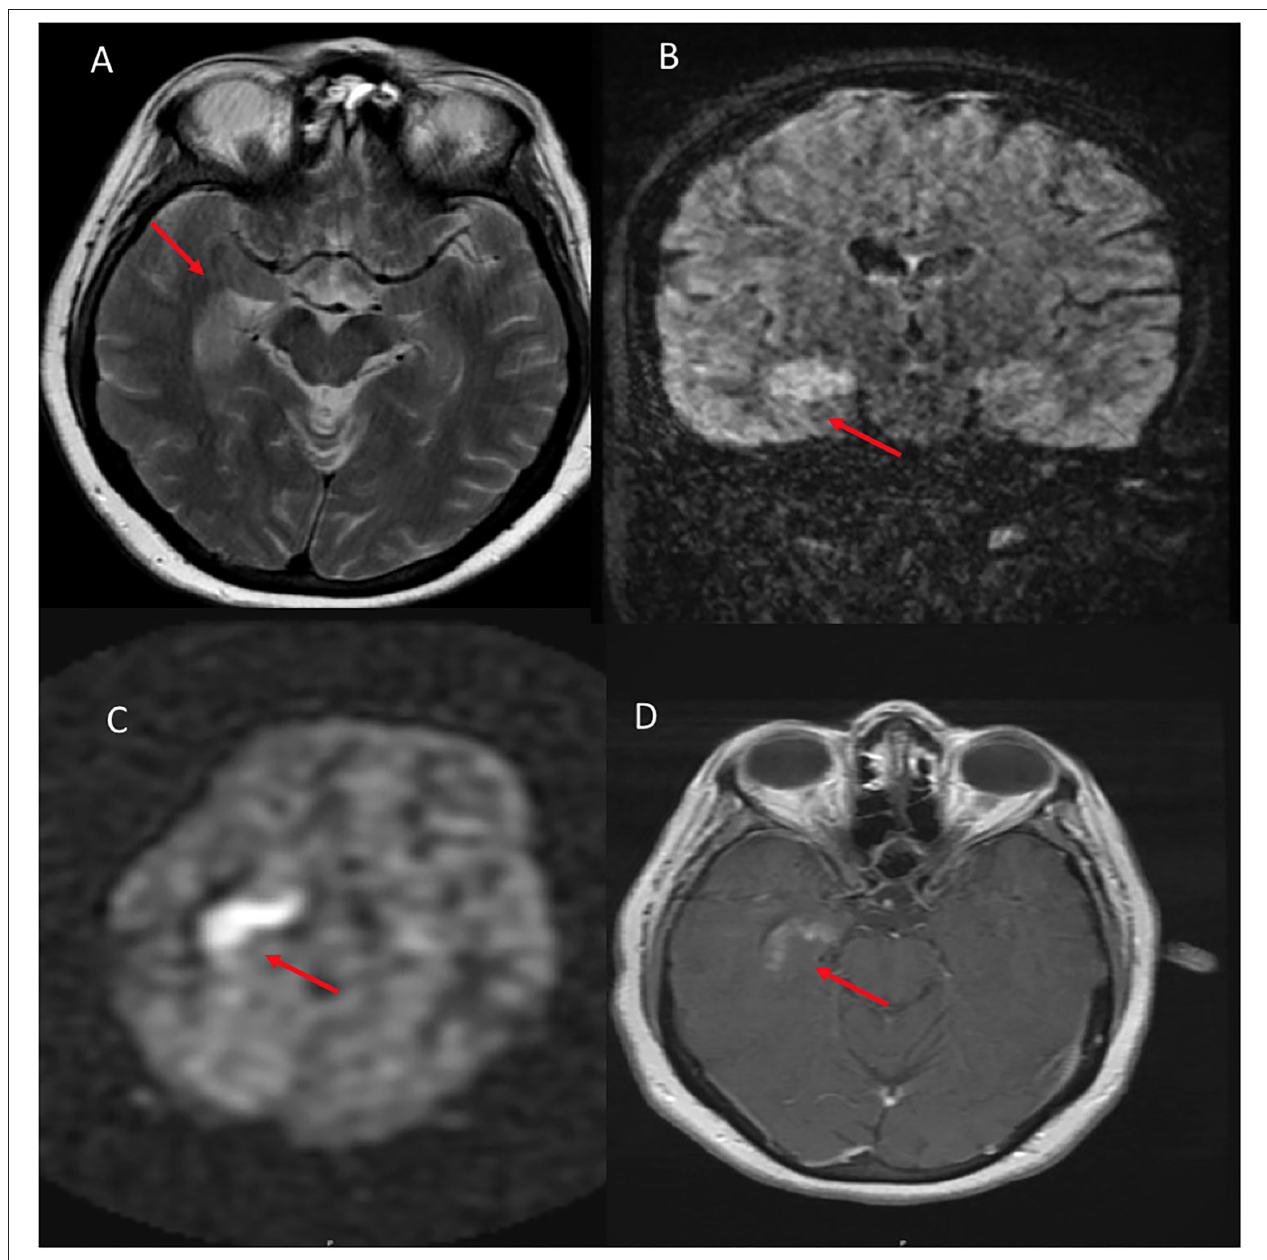
FIGURE 3 | A 54 year old female who presented with altered mental status and seizures. (A) Axial T2W demonstrates right hippocampal hyperintense signal. (B) Coronal FLAIR shows corresponding hyperintense signal in the same region. (C) ASL shows hyperperfusion in the right hippocampus and amygdala. (D) T1W postcontrast shows heterogenous enhancement of the same region.